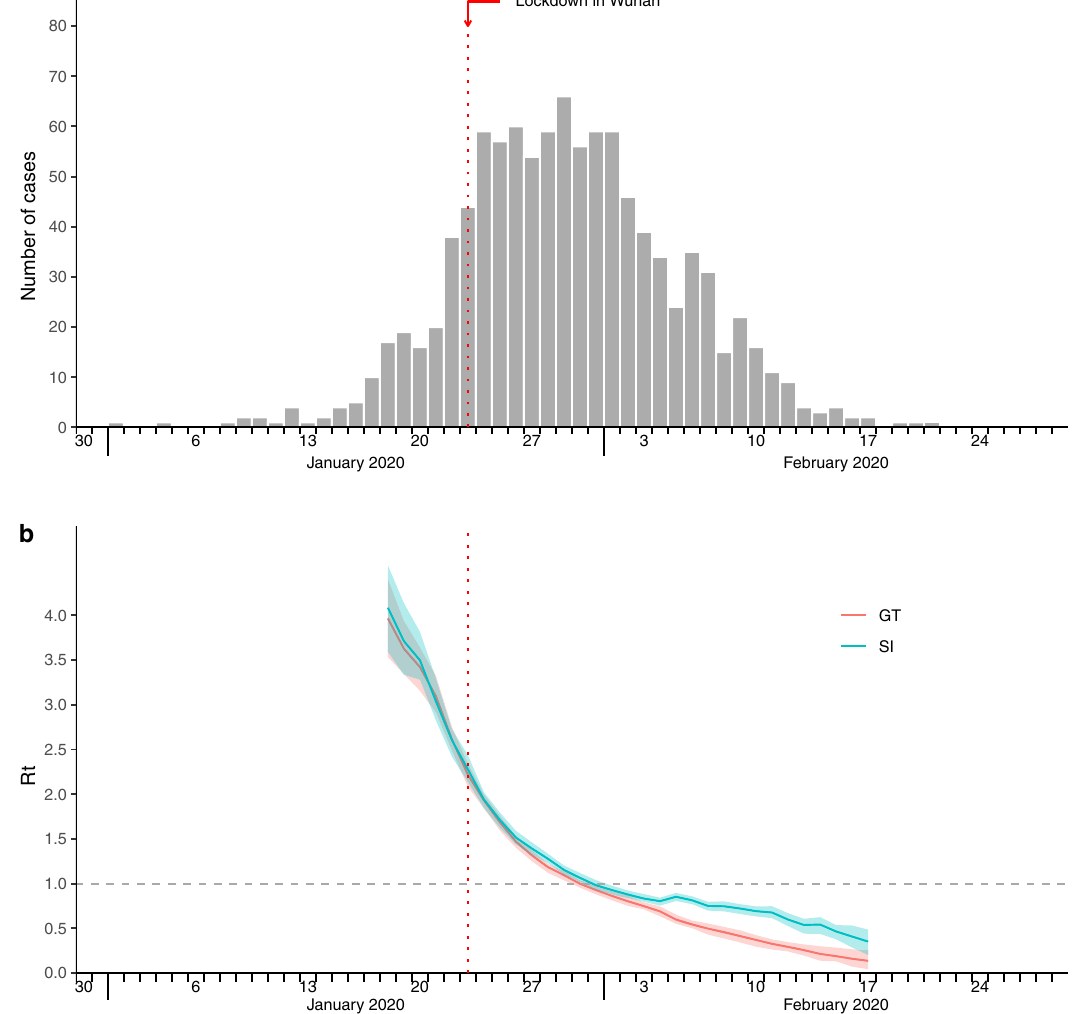
curve and temporal generation times (GT) with reference to infector onset, versus estimatesbasedonepidemiccurveandtemporalserialintervals(SI)withreference to infectoronset, shownasinredand teal,respectively. The solid linesand shaded areas are corresponding to the mean estimates and 95% con fi dence intervals of effective reproduction numbers,